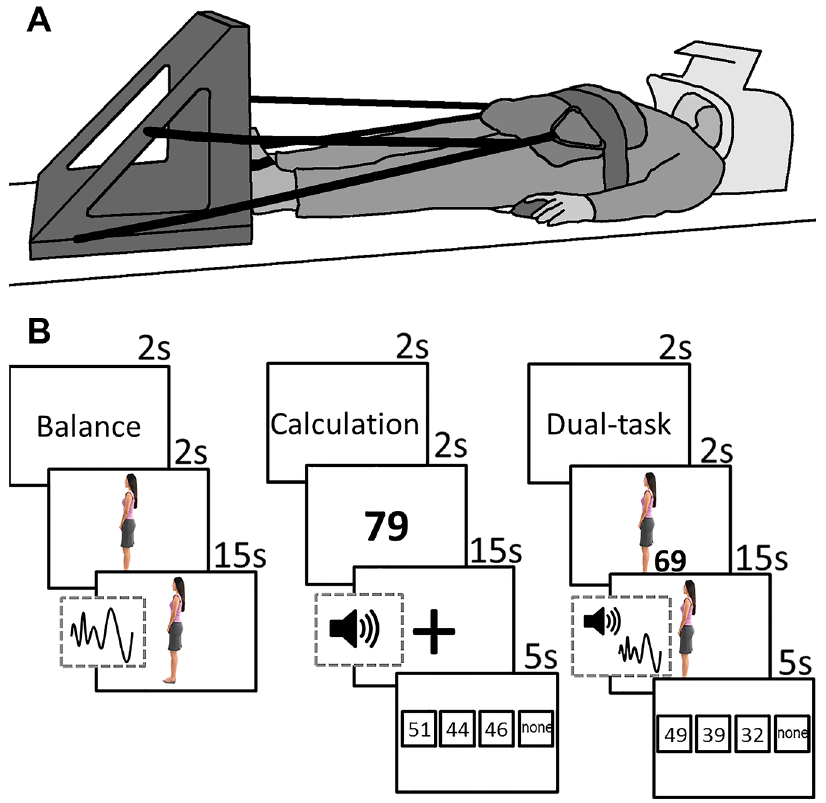
Fig 1. A: Illustration of experimental setup in the scanner. Participantlies supinewith her feet against the force platform. B: Schematic of the stimuli duringbalance, calculationand dual-task conditions. The sine wave signifiesthe additionof the disturbance signal, causingthe avatar to sway forward and backward. The speakersignifiesthe additionof beeps, which indicatedthe time points at which the participanthad to